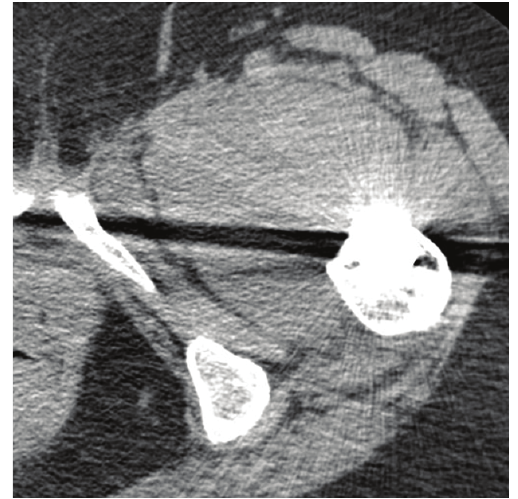
Figure 3: Axial section of CT scan showing hematoma in iliopsoas region.